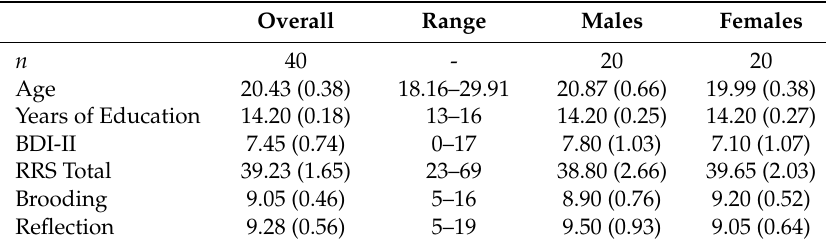
Standard errors of the mean appear in parentheses here and in all subsequent